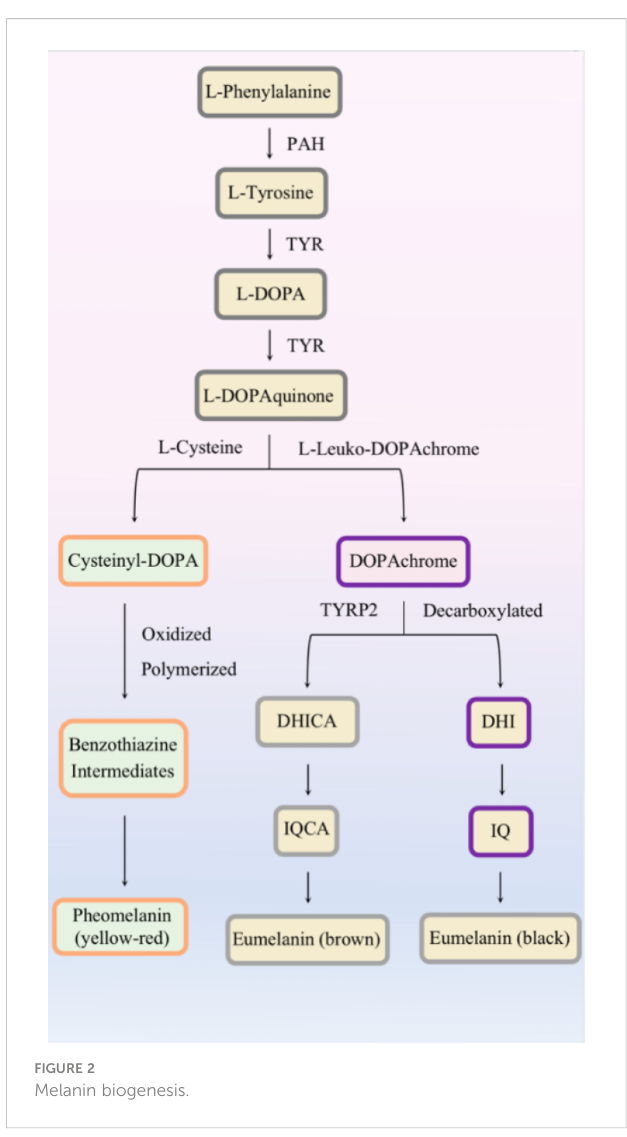
FIGURE 2 Melanin